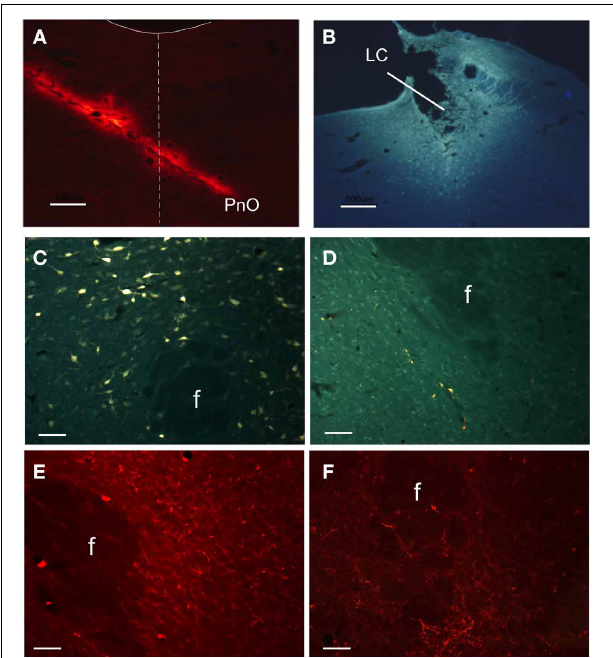
FIGURE 1 | Anatomical projections between PeFLH area and LC or PnO nuclei. (A) Microphotograph showing a representative case of FR injection aimed at PnO from the contralateral side. Dash line indicates midline; solid line indicates the IV ventricle contour. (B) Microphotograph of a FG injection aimed at LC. (C,D) Microphotographs showing labeled neurons in the PeF area after FG injection in PnO nucleus (C) and LC nucleus (D) . (E,F) Microphotographs of two cases showing fiber terminals after FR injections in PnO nucleus (E) and LC nucleus (F) . f: fornix. Calibration bars in (A) and (B) , 500 μ m. Calibration bars in (C–F) , 150 μ m.